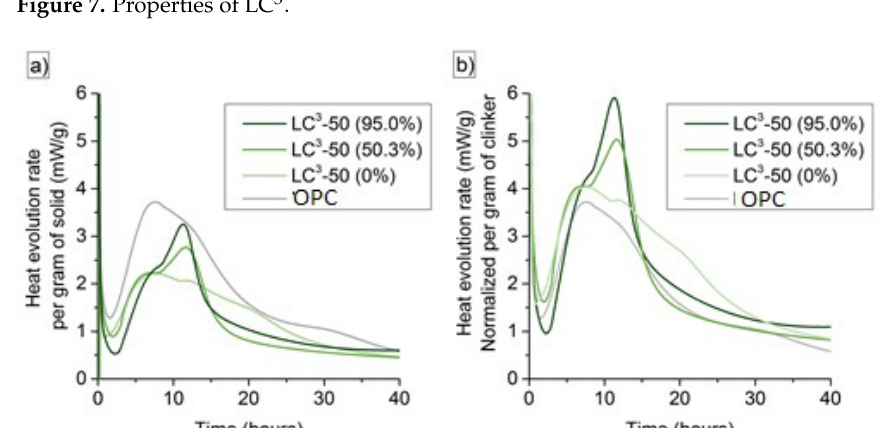
Figure 8. Heat evolved: ( a ) normalized clinker ( b ) for PC, LC 3 -50 at 0%, 50.3%, and 95.0% [70].